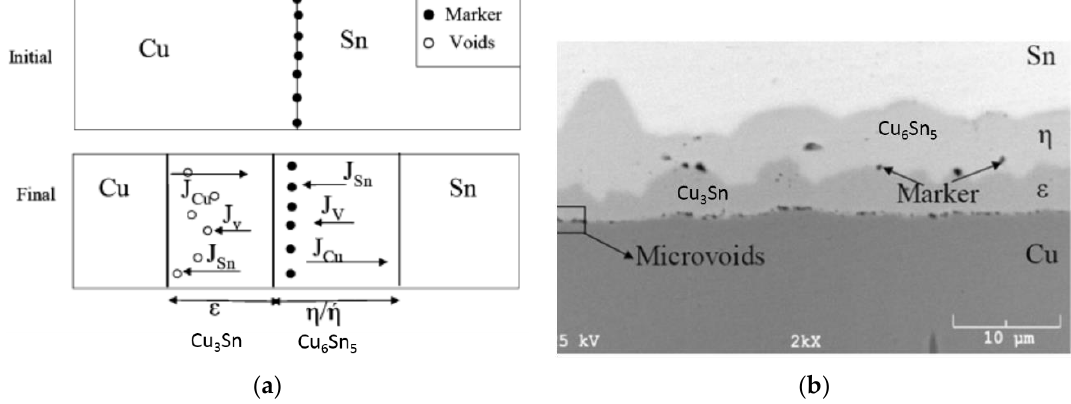
Figure 12. ( a ) Schematic illustrating the Kirkendall void formation in the copper-tin (Cu-Sn) diffusion couple. Relative flux of Cu and Sn interdiffusion can be determined using inert markers. The diffusion rate of Cu into intermetallic compound (IMC) layers exceeds the rate of the diffusion of Sn into IMC layers leading to vacancies at the Cu/IMC interface; ( b ) Corresponding scanning electron microscope (SEM) micrograph depicting marker location and void formation [119]. Reprinted with permission from the Journal of Phase Equilibria and